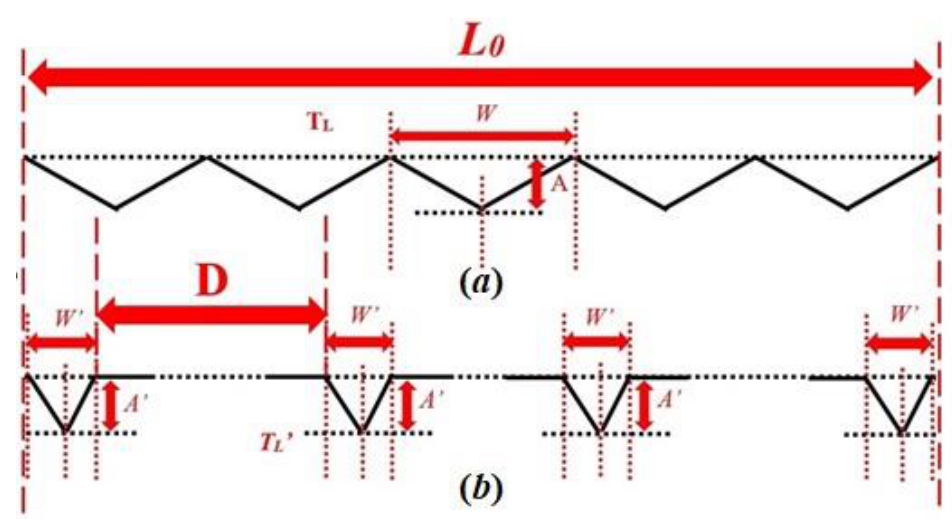
Figure 29. Schematic diagram describing the relationship between tortuosity and width of interfacial roughness imperfection for multiple imperfections. The total tortuosity might be identical for both of interfacial roughness profile characterized by ( a ) lower individual tortuosity with wider width, ( b ) higher individual tortuosity with narrower